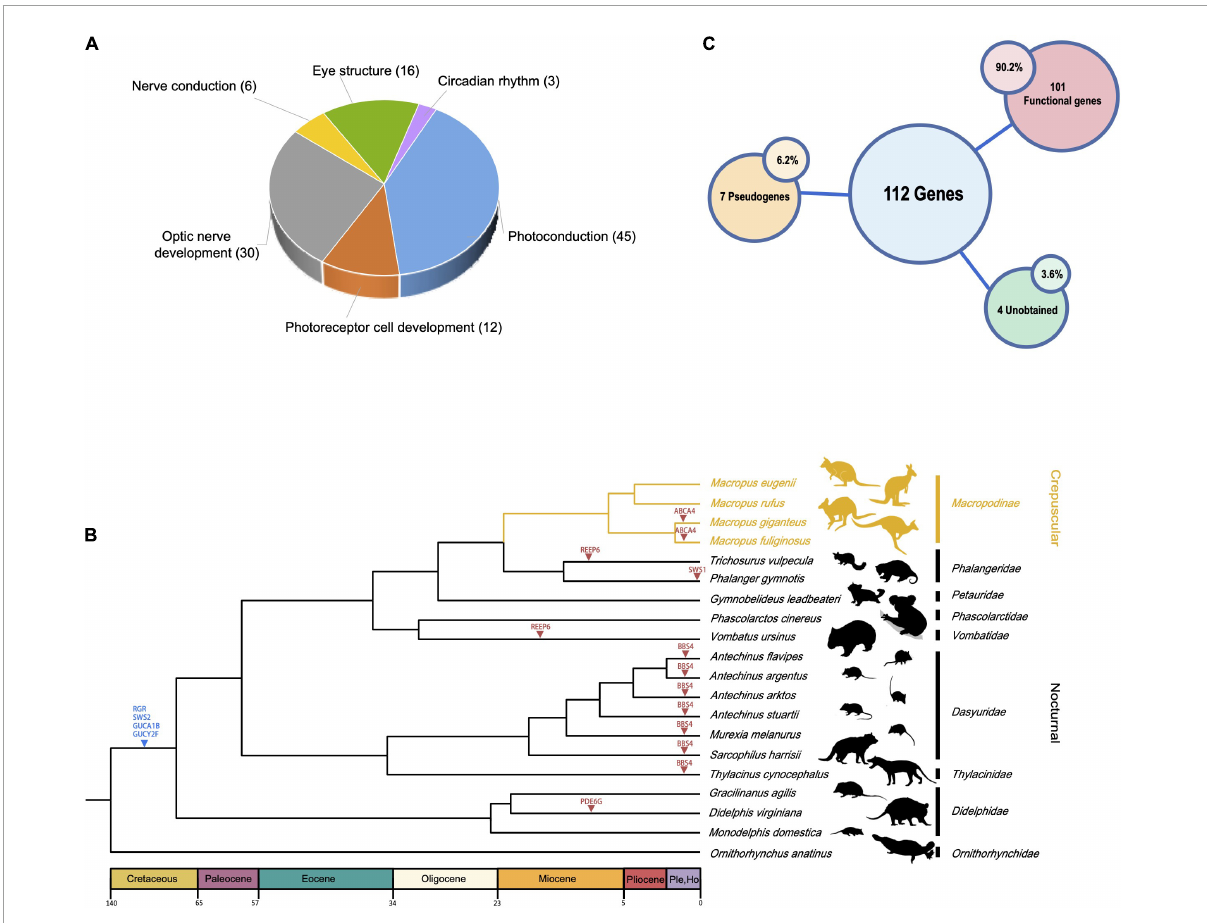
FIGURE2 Overview of vision-related genes examined and species tree of marsupials. (A) Pie diagram showing broad functional categories of the 112 vision-related genes investigated. (B) Phylogenetic relationships of 19 marsupial species. The crepuscular Macropus lineage is shown in yellow. Four genes lost in the ancestor of marsupials are indicated by a blue triangle, pseudogenes found in one or more lineages as a red triangle. Silhouettes of mammalian species are reproduced from http://phylopic.org under a Public Domain or Creative Commons license. (C) Overview of the number of genes in (A) that are lost in all marsupials (“Unobtained”), pseudogenes (in at least one marsupial), and genes intact in all marsupials (“Functional